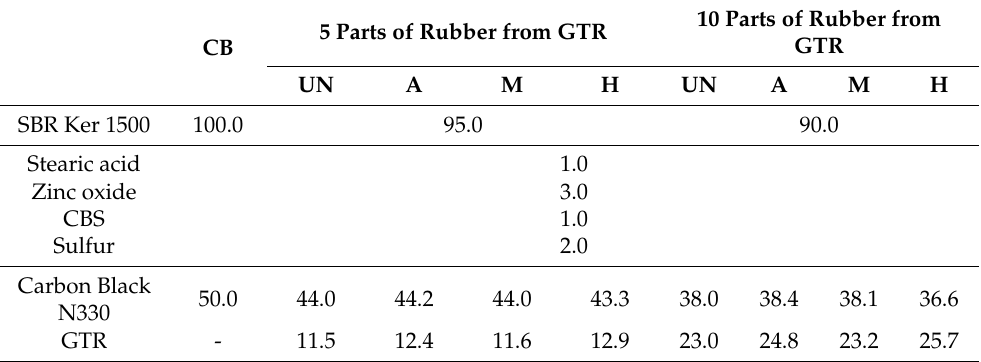
Table 1. Composition of the rubber mixes studied